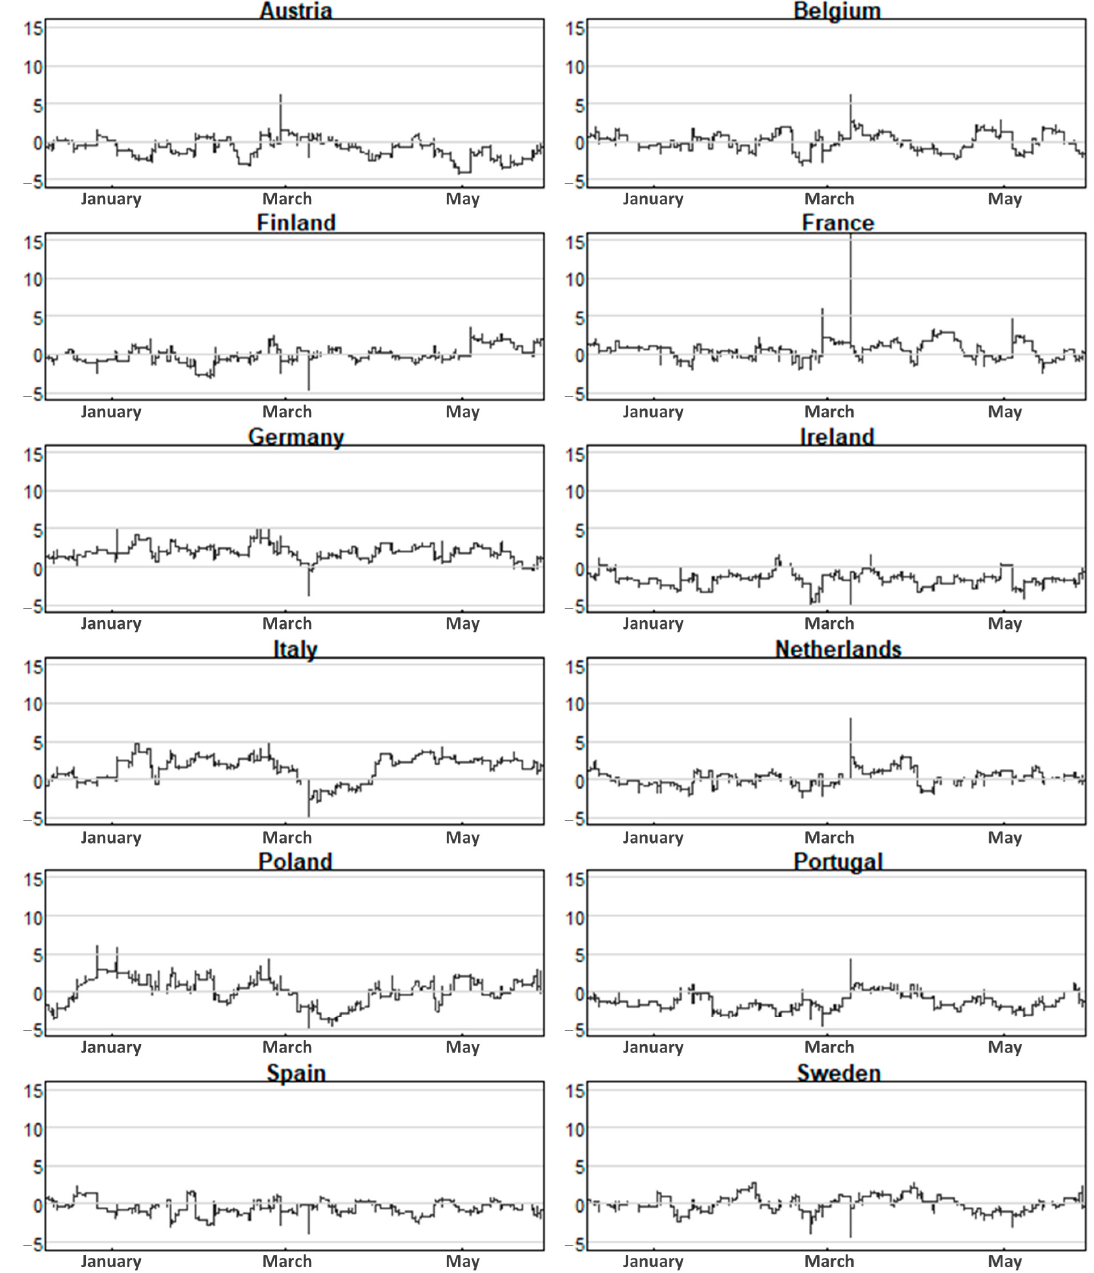
Figure 4. Net Intraday volatility spillovers in European Markets during